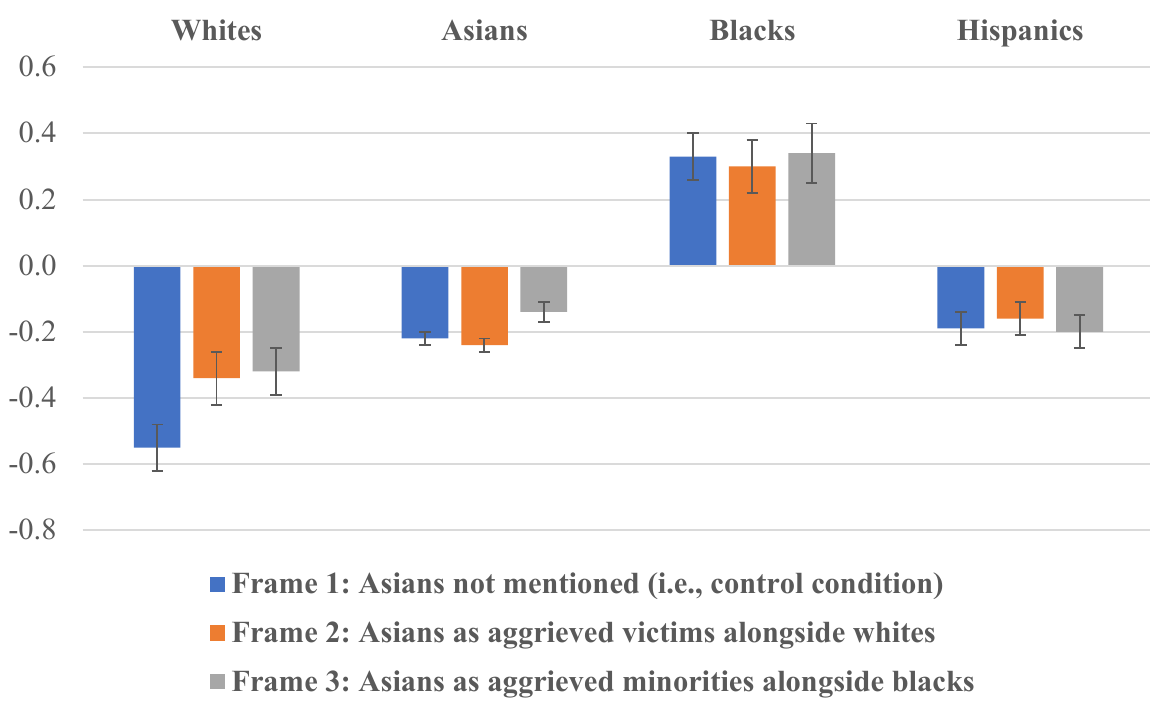
Figure 2: Differences in mean support for preferential hiring and promotion by frame and race. Whiskers are standard errors. Full details on t tests and p values are included in Table A2 of the online supplement. Source: 2016 National Asian American